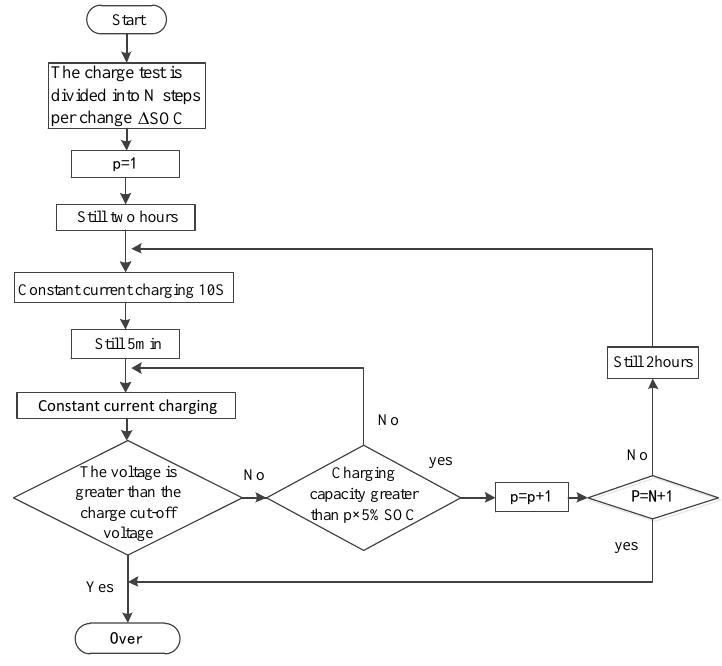
Figure 2. Test flow of battery model parameters.